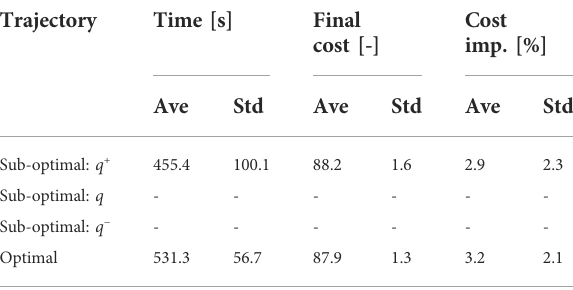
TABLE 5 Simulation result in terrain roughness 0.281 (goal A): C 0 =90.9 ± 1.7.